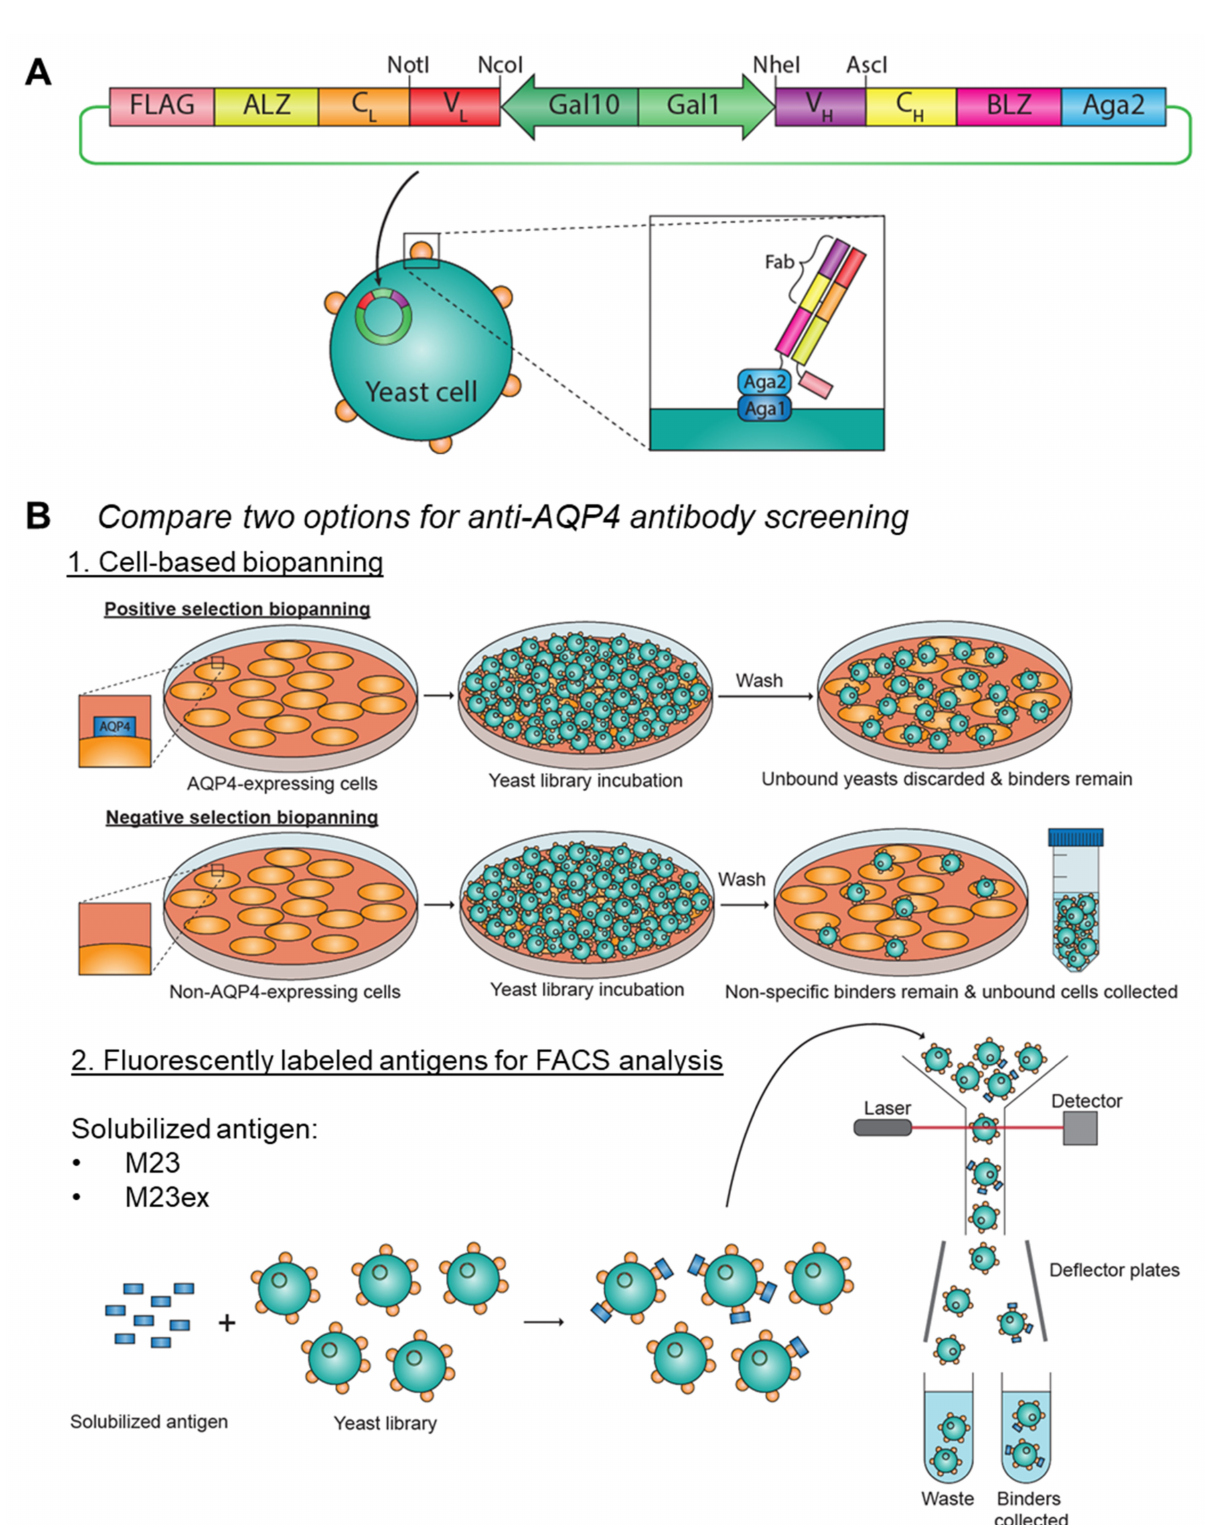
Figure 1. Yeast surface display and screening strategies. ( A ) Overview of the yeast surface display system. Fab expression vector contains a galactose-inducible bidirectional promoter Gal1/Gal10 for the transcription of the variable and constant heavy chains (V H and C H ), and variable and constant light (V L and C L ) chains; as well as the acidic and basic leucine-zipper (ALZ and BLZ) dimerization domains, and the FLAG protein tag. The NheI and AscI restriction sites and NotI and AscI